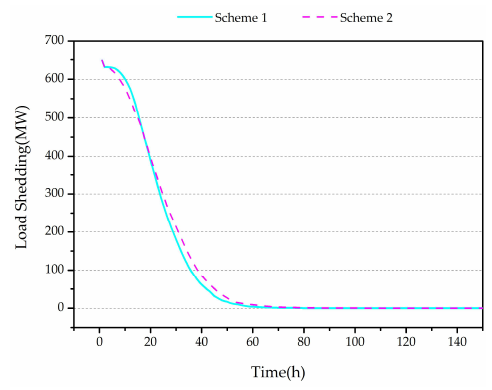
Figure 7. Load restoration process.